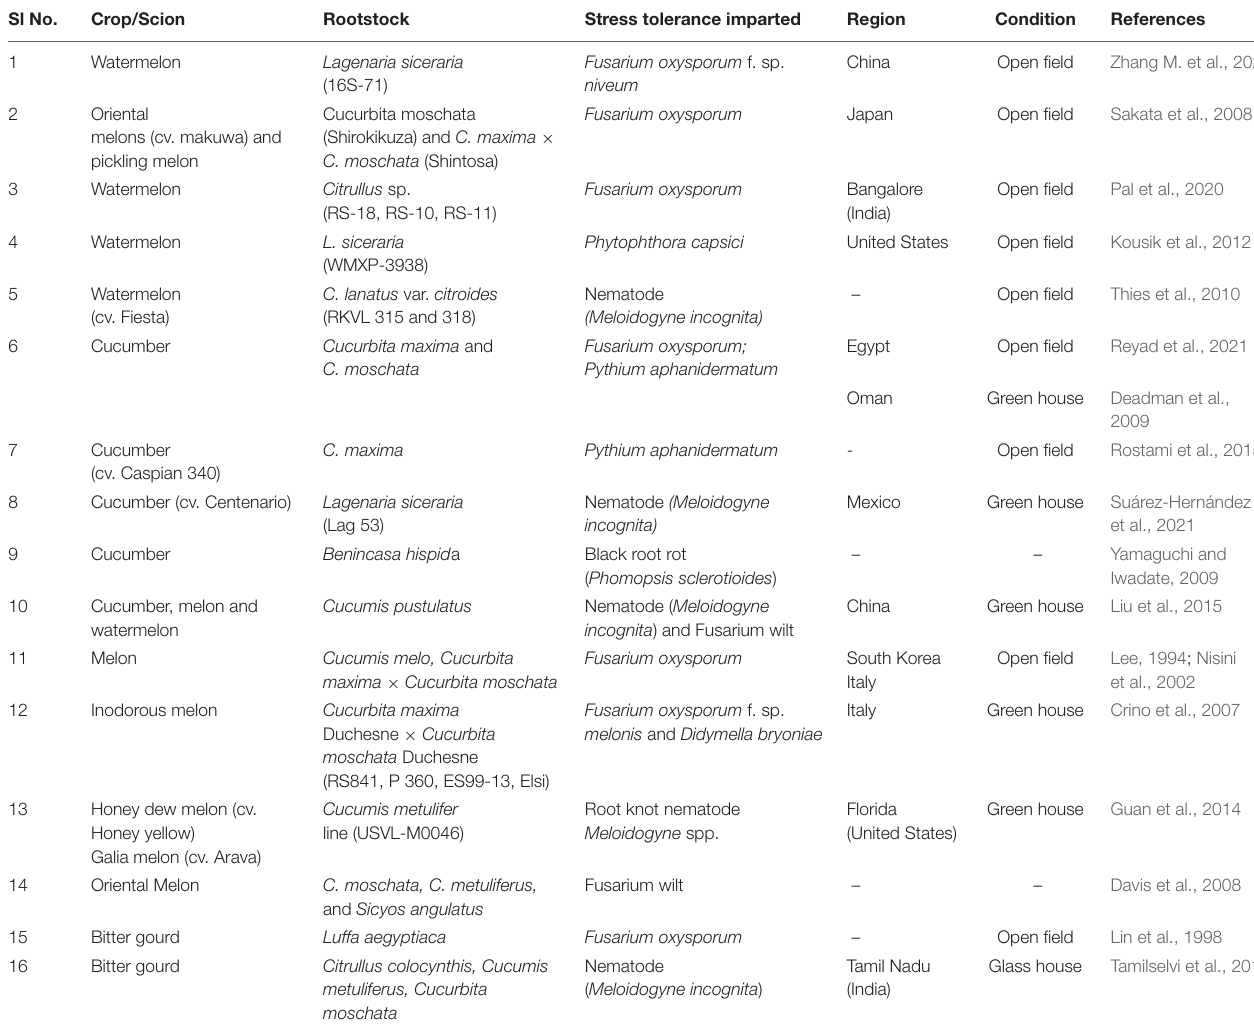
TABLE 5 | Rootstocks for combating biotic stress in cucurbits. Sl